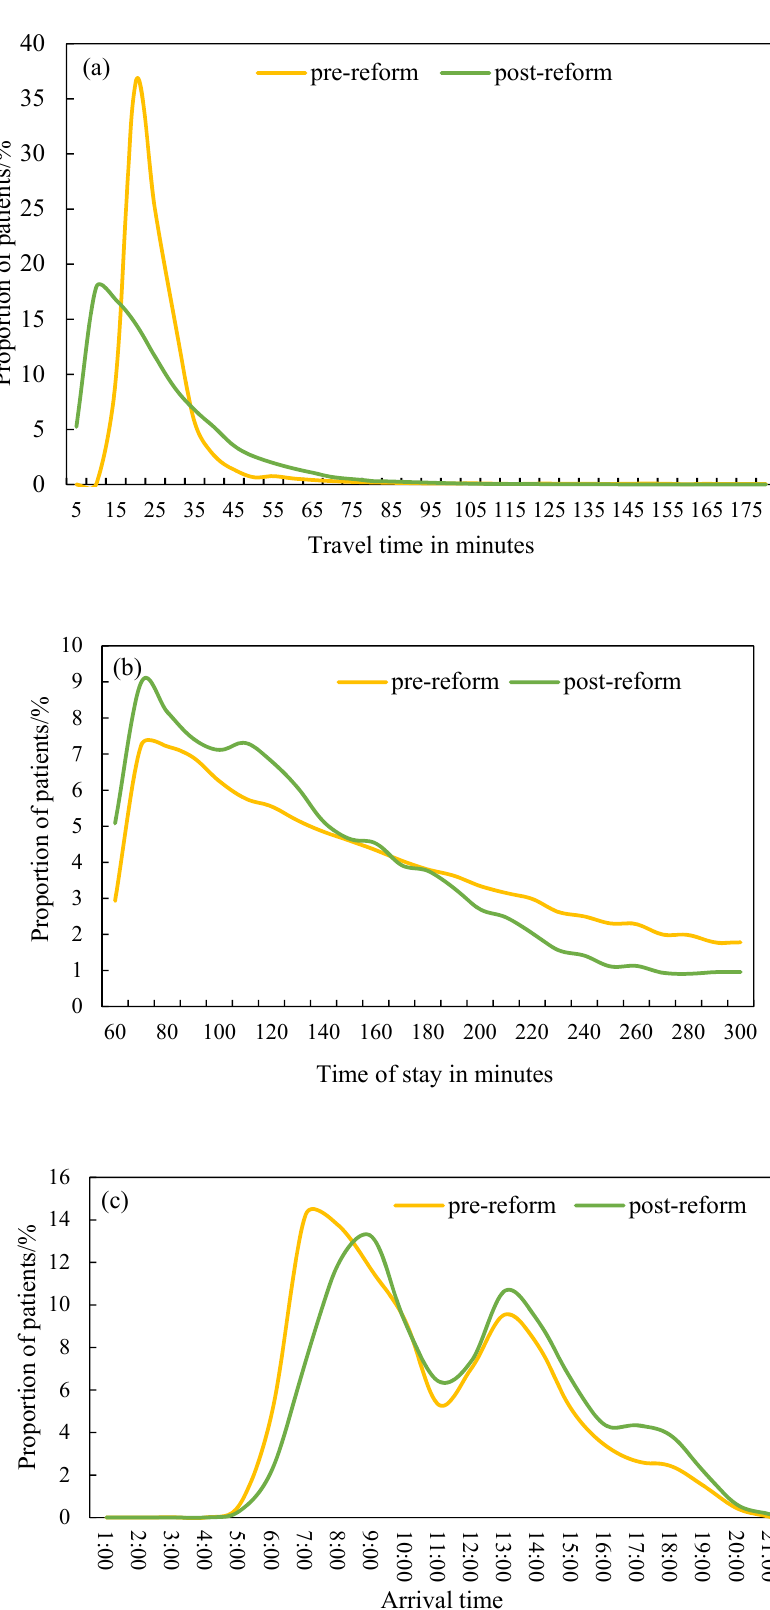
Figure 5. Frequency distributions of travel time to hospitals ( a ), time of stay at hospitals ( b ), and arrival time ( c ) for both pre-reform and post-reform data.